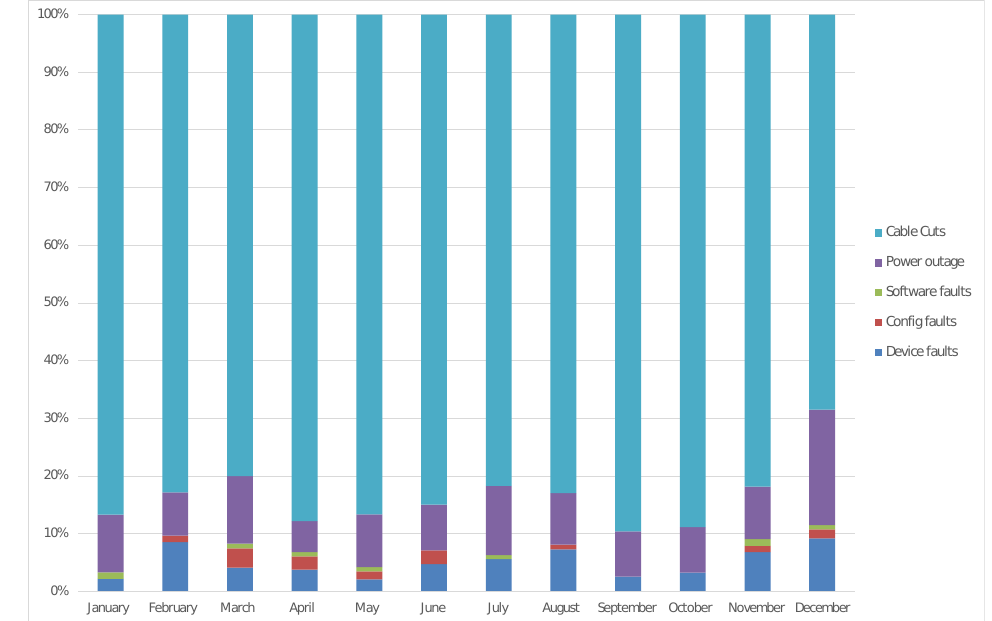
Figure 2. Reasons for service disruptions.